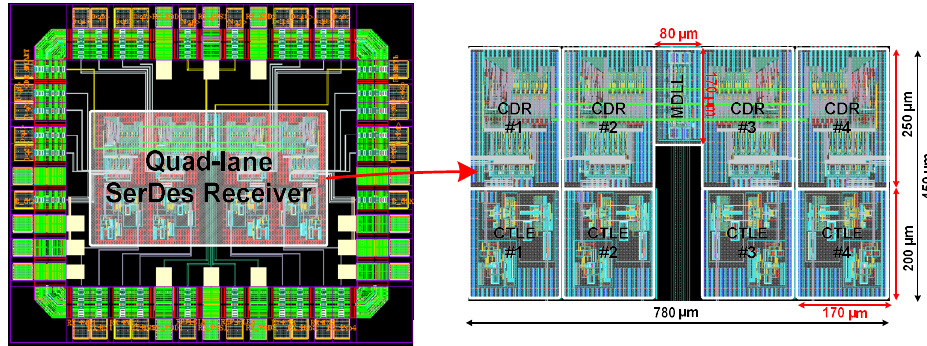
Figure 10. Layout of the proposed quad-lane SerDes receiver core block.